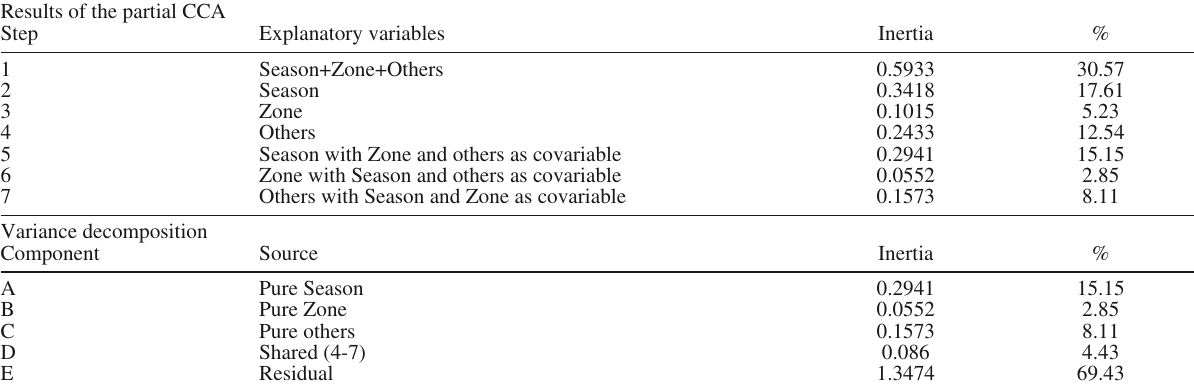
Variance decomposition